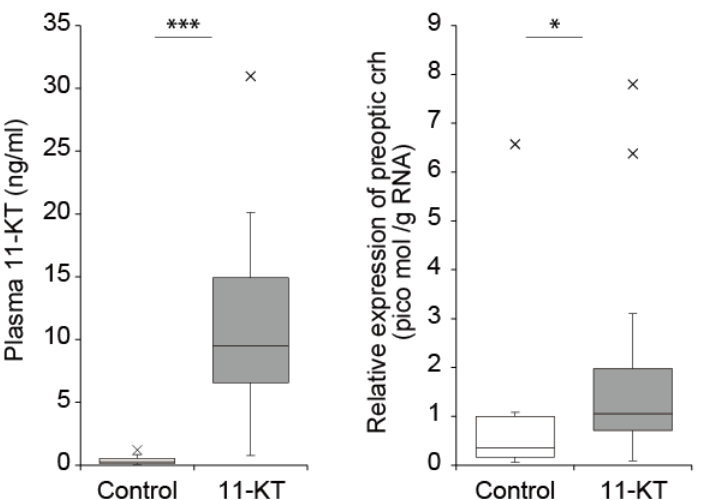
Figure 6. Plasma 11-KT and preoptic crh mRNA levels in female Japanese eels ( n = 12) ( A. japonica ) with intraperitoneal administration of 11-KT by osmotic minipump. Data are expressed as Tukey’s boxplots. *, *** significantly different from the control group at p < 0.05, 0.001 by Mann-Whitney U test, respectively. Cross marks indicate outliers.